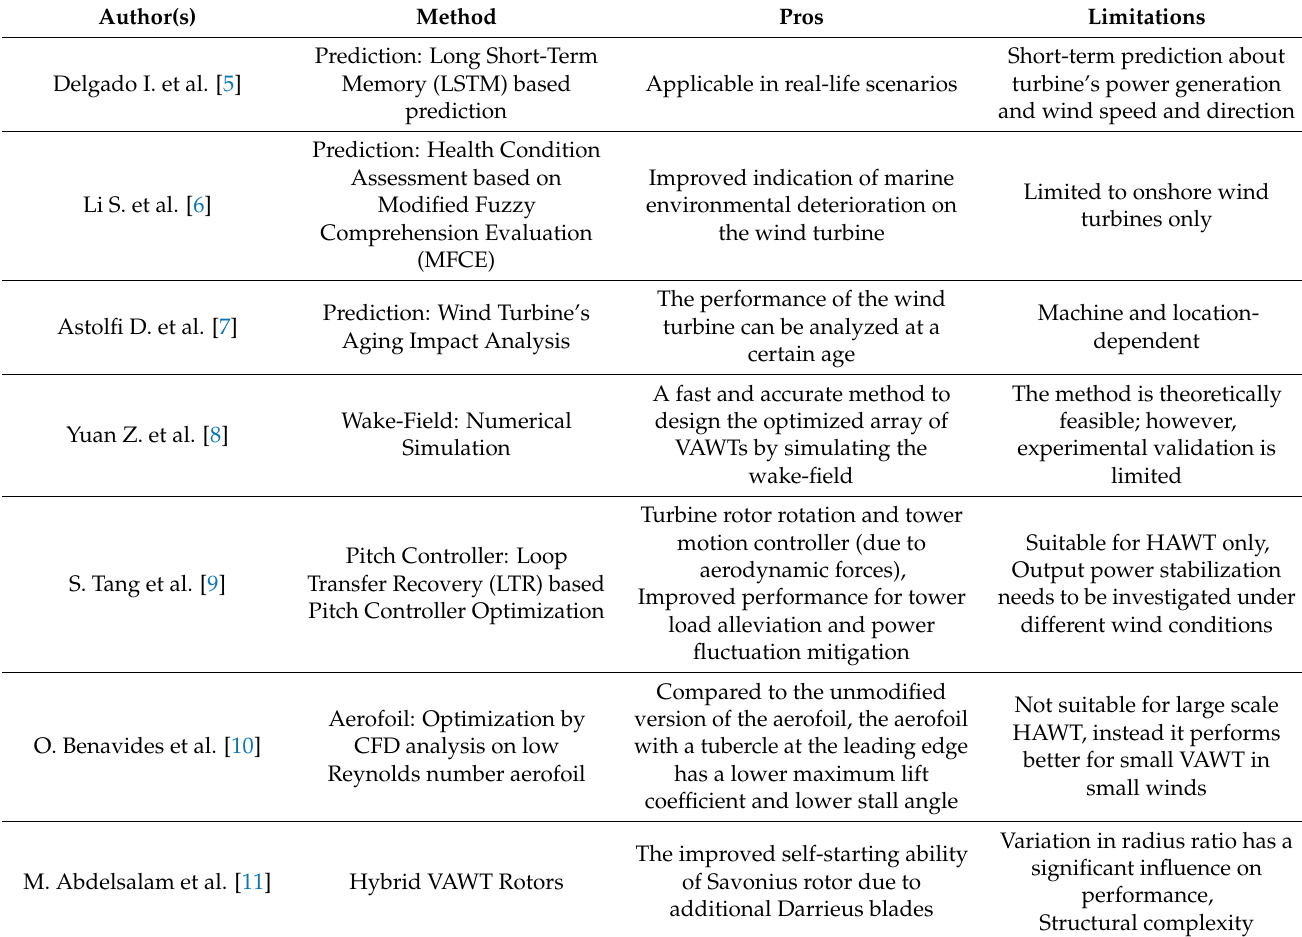
Table 1. Summary of performance enhancement methods for the wind